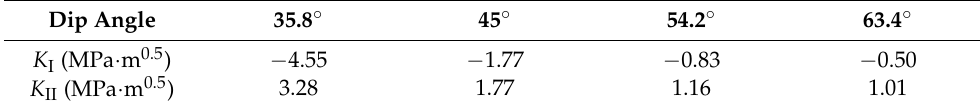
Table 2. Stress intensity factors of interface crack with different inclination angles.